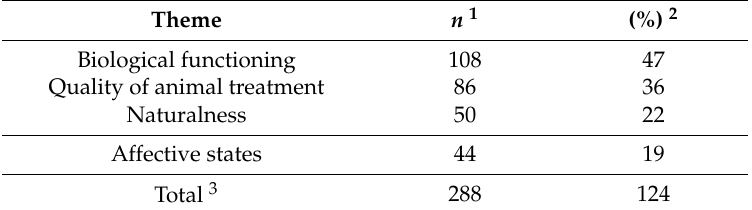
Table 2. Emerging themes in response to the question, In previous research done by our team, some people have told us that an ideal dairy farm should pay attention, among other things, to the welfare of their animals. If you agree with that statement, can you tell us what would you expect of a dairy farm that takes care of the welfare of their animals? ( n = 228